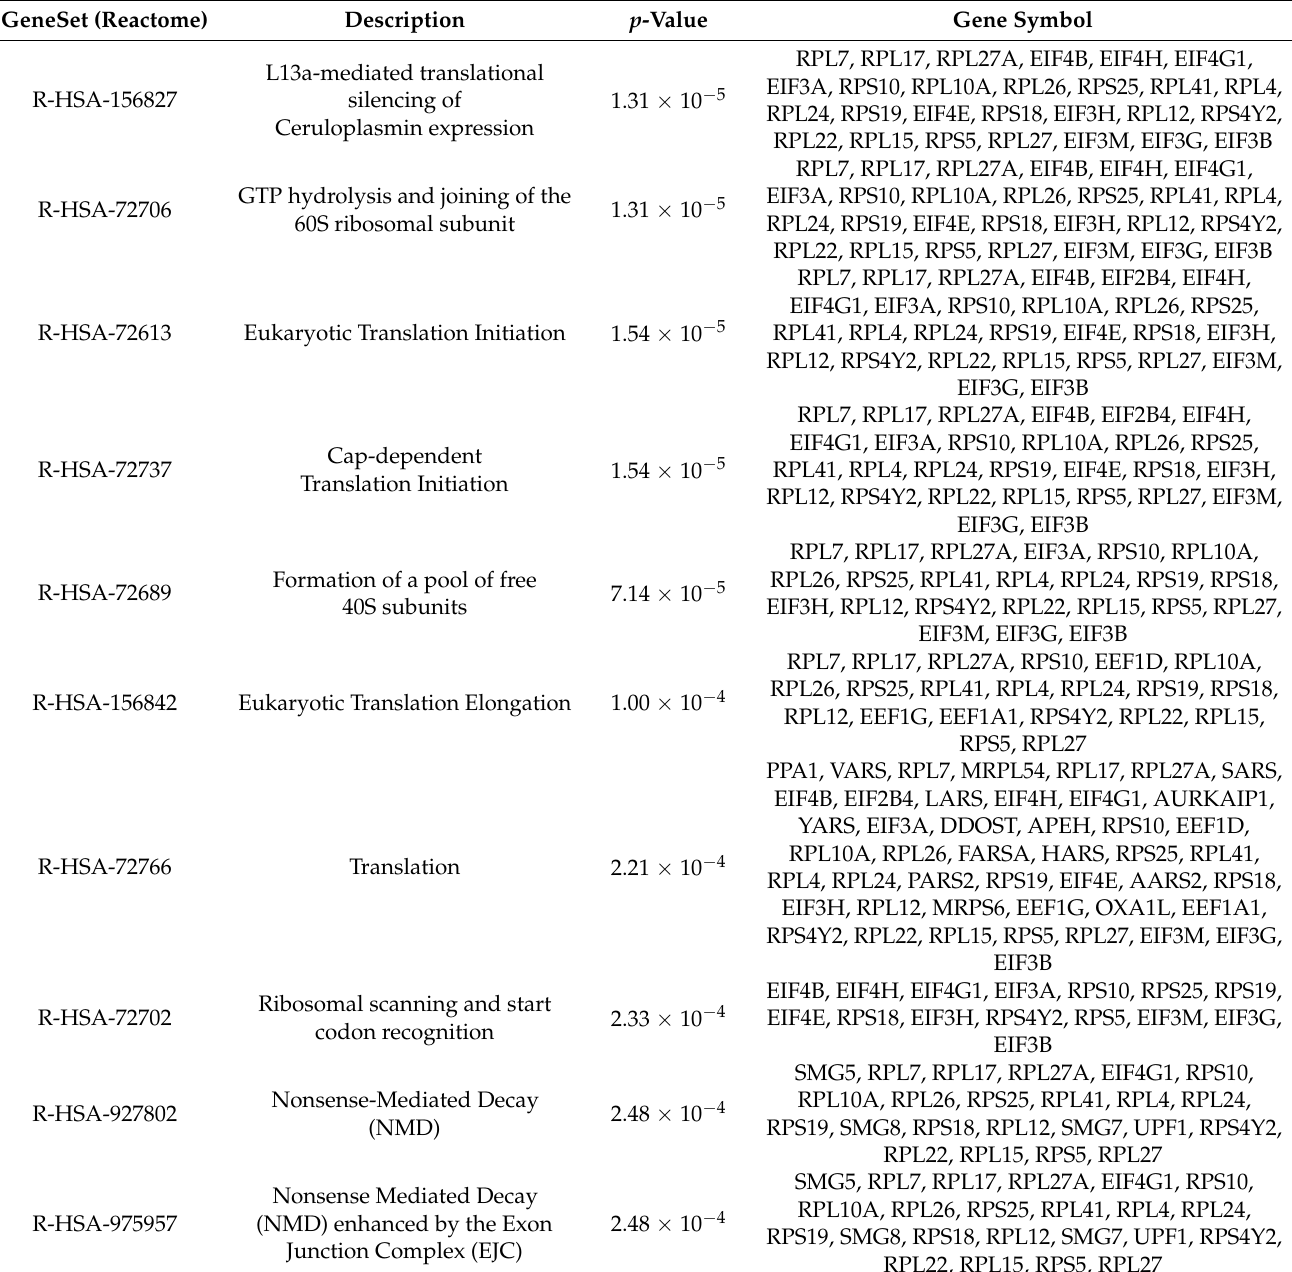
Table 4. Top 10 identified gene sets in the WebGestalt analysis for DIRAGs higher reactive in seroposi- tive (A) and seronegative RA (B) and PIA animals (C) during the disease onset period (24 days after pristane induction). Reactome GeneSet and link to Reactome pathway browser, gene set description, the respective p -value and GeneSymbols of significantly higher reactive DIRAGs are